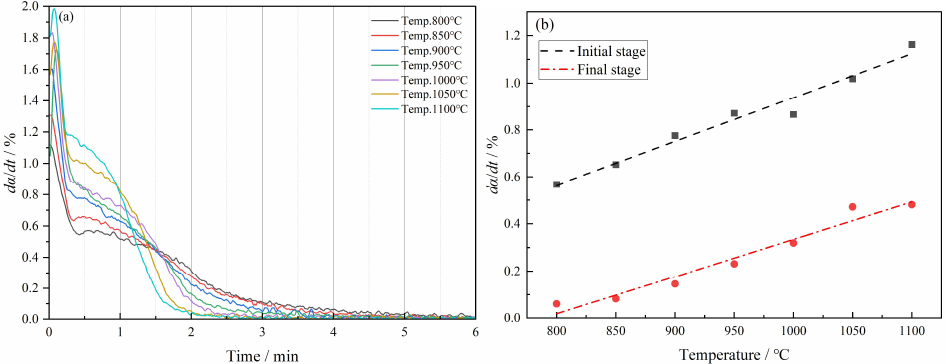
Figure 5. ( a ) Variation of reduction rate of iron ore fines with reaction time, and ( b ) Effect of the reduction temperature on the initial and final rate of reduction.